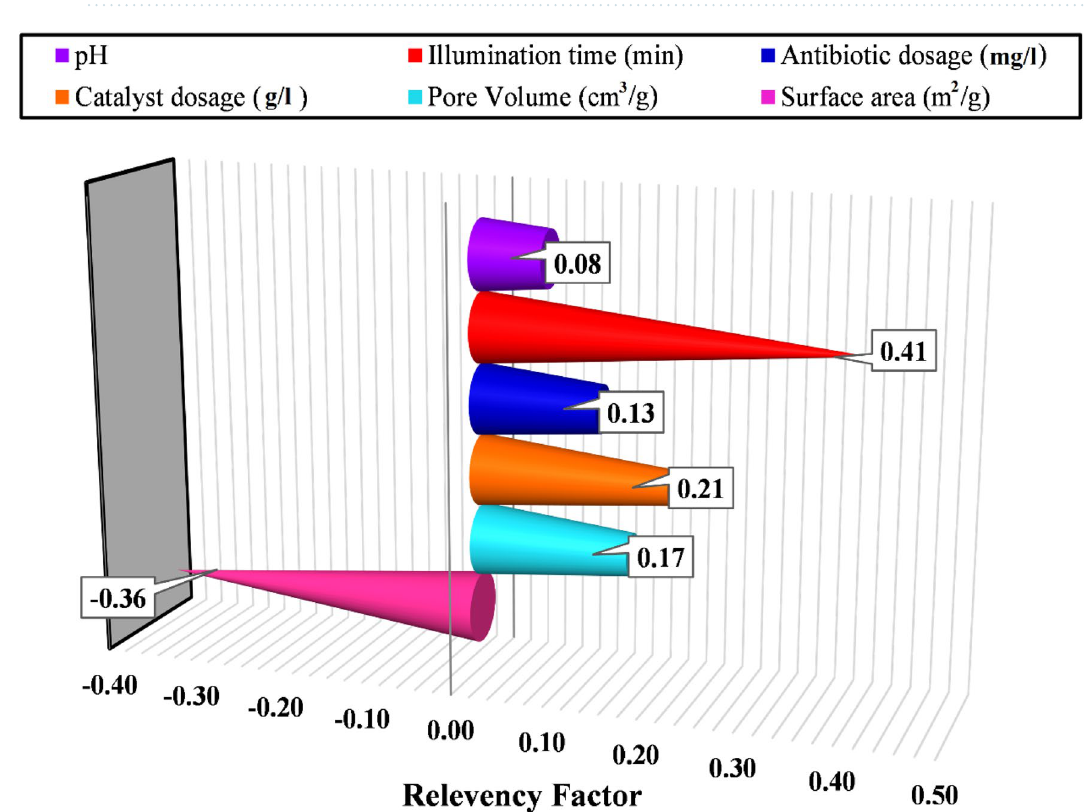
Figure 2. Sensitivity analysis of the input operational variables for TC photodegradation by various